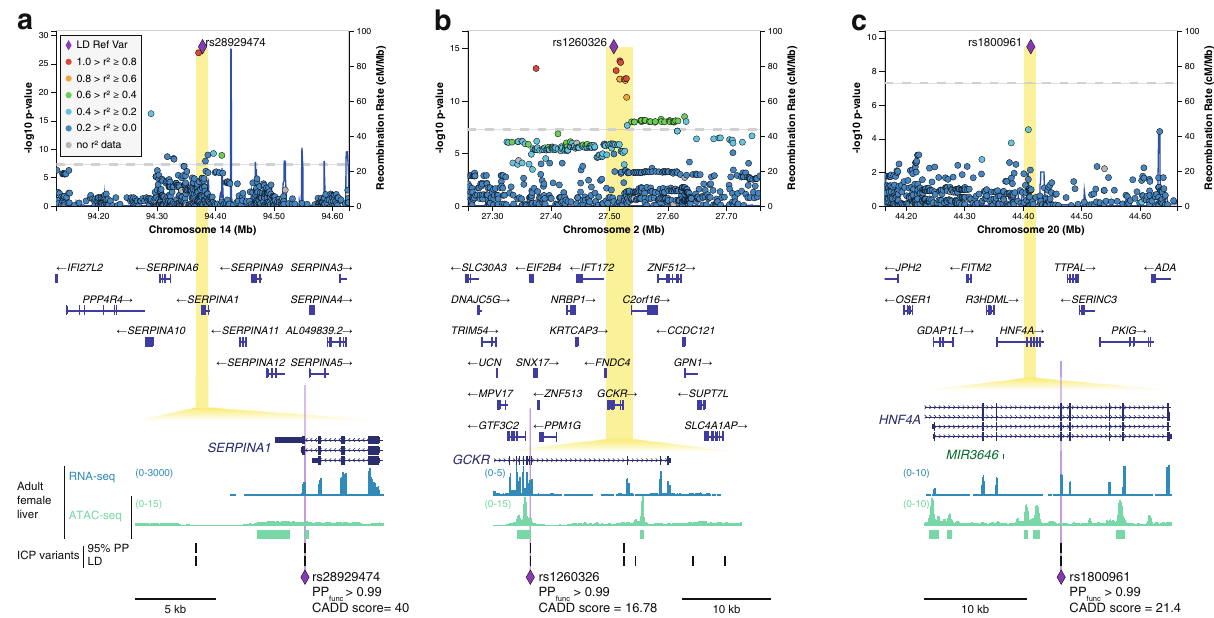
Fig. 3 Analysis of intrahepatic cholestasis of pregnancy (ICP) association signals uncovers three coding risk variants affecting the SERPINA1 , GCKR , and HNF4A genes. a – c Regional association and linkage disequilibrium (LD) plots for the ICP signals at SERPINA1 , GCKR , and HNF4A , respectively. The y axis represents the − log 10 ( P ) values for the association test from the GWAS meta-analysis of ICP (1138 cases and 153,642 controls) and the x axis the chromosomal positions (GRCh38/hg38). The SNP with the lowest p-value in the locus is indicated by a purple diamond. The remaining SNPs in the region are colored according to their r 2 with the lead SNP ( r 2 calculated using 1000 Genomes European (EUR) reference). The dotted gray line represents the genome-wide signi fi cance threshold of 5 × 10 − 8 . Plots were generated using LocusZoom 61 . Association testing was performed as described in Fig. 1. Zoomed insets reveal the prioritized coding variant at each locus, with functional posterior probability (PP func ) above 0.99. PP func were calculated using PAINTOR 17 . All three variants showed Combined Annotation Dependent Depletion (CADD) scores 19,84 above 10, which is usually considered the threshold for pathogenic variants. Further details on coding variant analysis are provided in Supplementary Data 3. 95% PP ICP variants, variants within the 95% genetic credible set in the ICP meta-analysis. LD ICP variants, variants with EUR r 2 > 0.8 with the meta-analysis lead